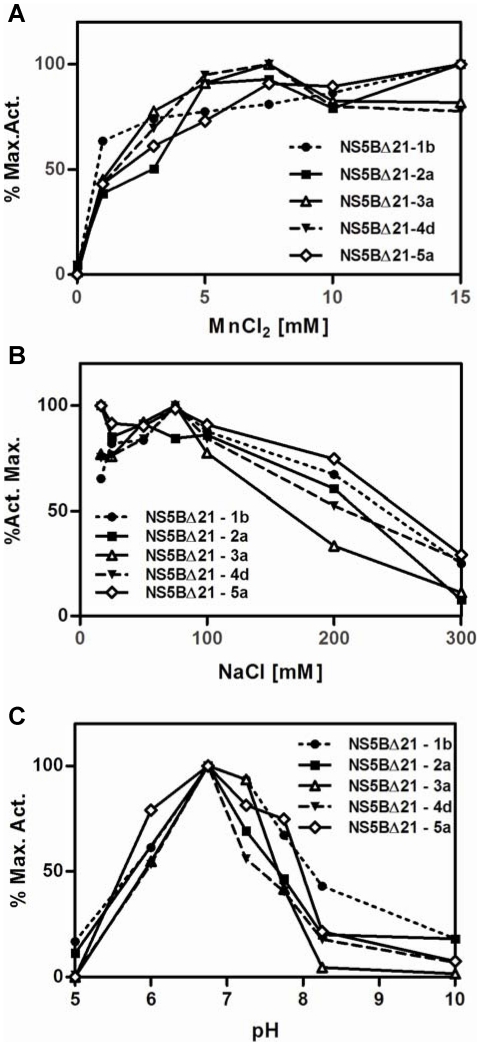
Characterization of the conditions for optimal RNA synthesis in a “de novo” initiation process by polymerases from different genotypes.The ability of each polymerase to synthesize poly-G from [α-32P]GTP using poly-C template is normalized with respect to its maximum activity. The effect of the following conditions was analyzed: A) MnCl2 concentration (metal ion requirements), B) pH and, C) NaCl concentration (ionic strength). Reaction mixtures contained 125 µM GTP and 40 ng/µl of polyC. Reactions in panel B) were performed with different buffers according to the selected pH: sodium acetate for pH 5, MES for pH 6, MOPS for pH 7.25, HEPES for pH 7.75, Tris-HCl for pH 8.25 and CAPS for pH 10. All graphs show means of at least three independent experiments. Error bars were lower than 20% in all points and have been removed for clarity.